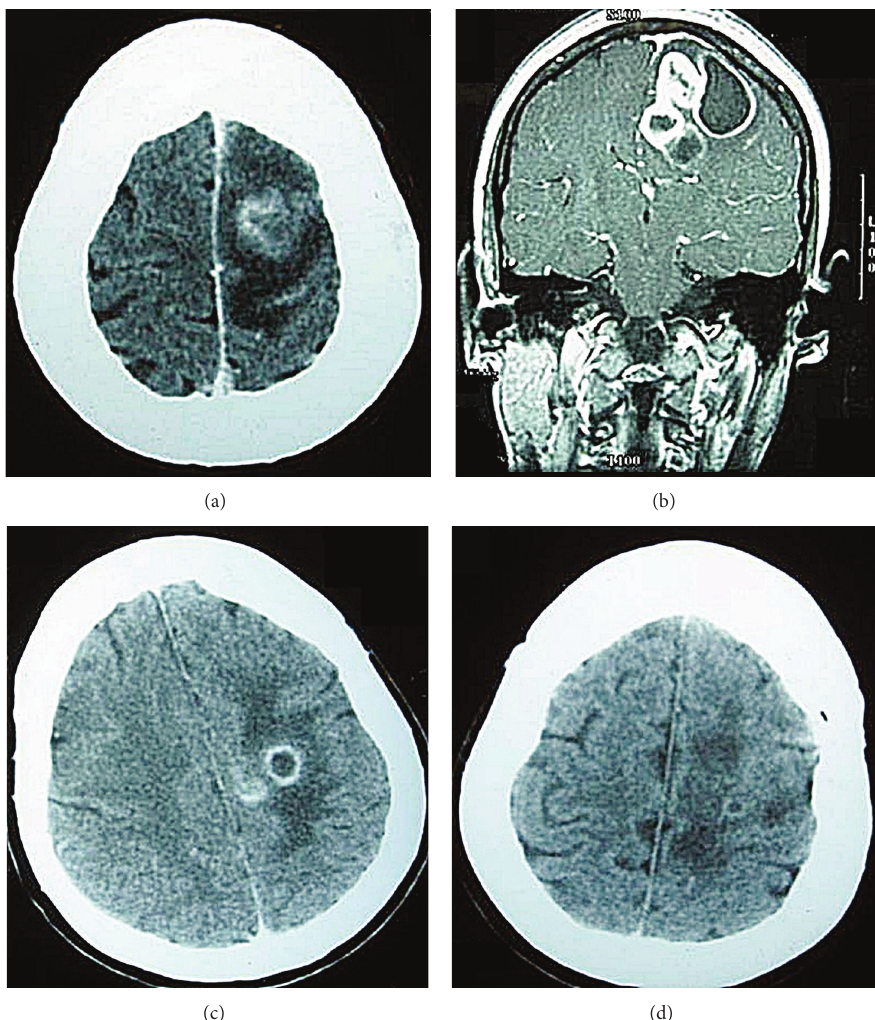
Figure 1: (a) Brain computed tomography (CT) showed ring enhanced nodules with extensive perifocal edema over left frontoparietal region on February 16, 2002. (b) Coronal enhanced T1-weighted magnetic resonance image (MRI) on February 26, 2002, showed multiple conglomerated lesions over left posterior frontal lobe with enhancement. (c) Brain CT on April 8, 2002, and (d) April 15, 2002, showed the gradual regression of the